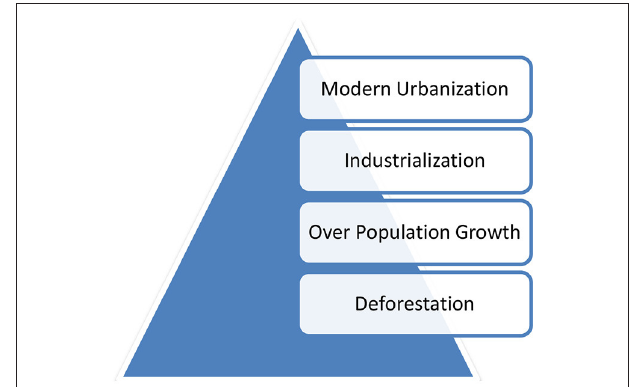
FIGURE 7 | Triangle of environment